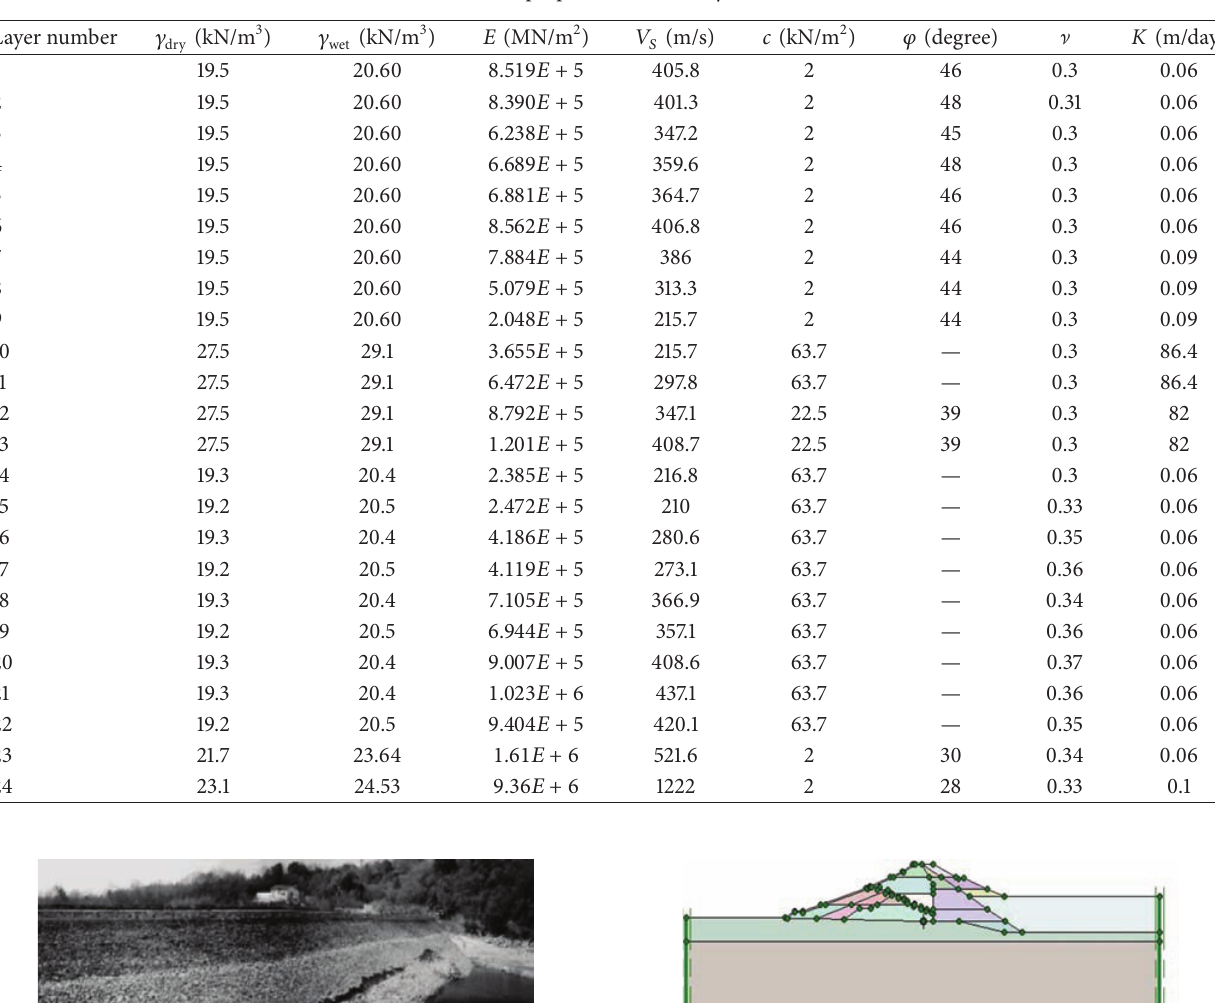
Table 3: Soil properties of the Kitayama dam.